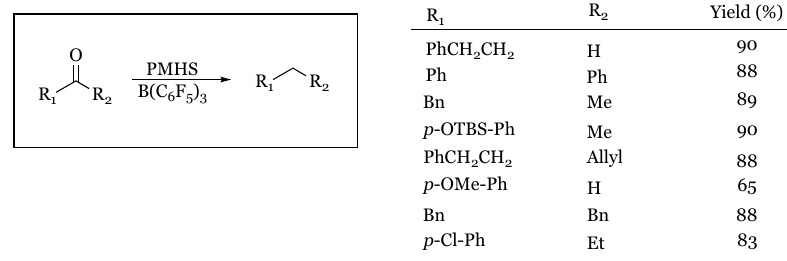
Figure 26. Defunctionalization of carbonyl groups using polymethylhydrosiloxane.